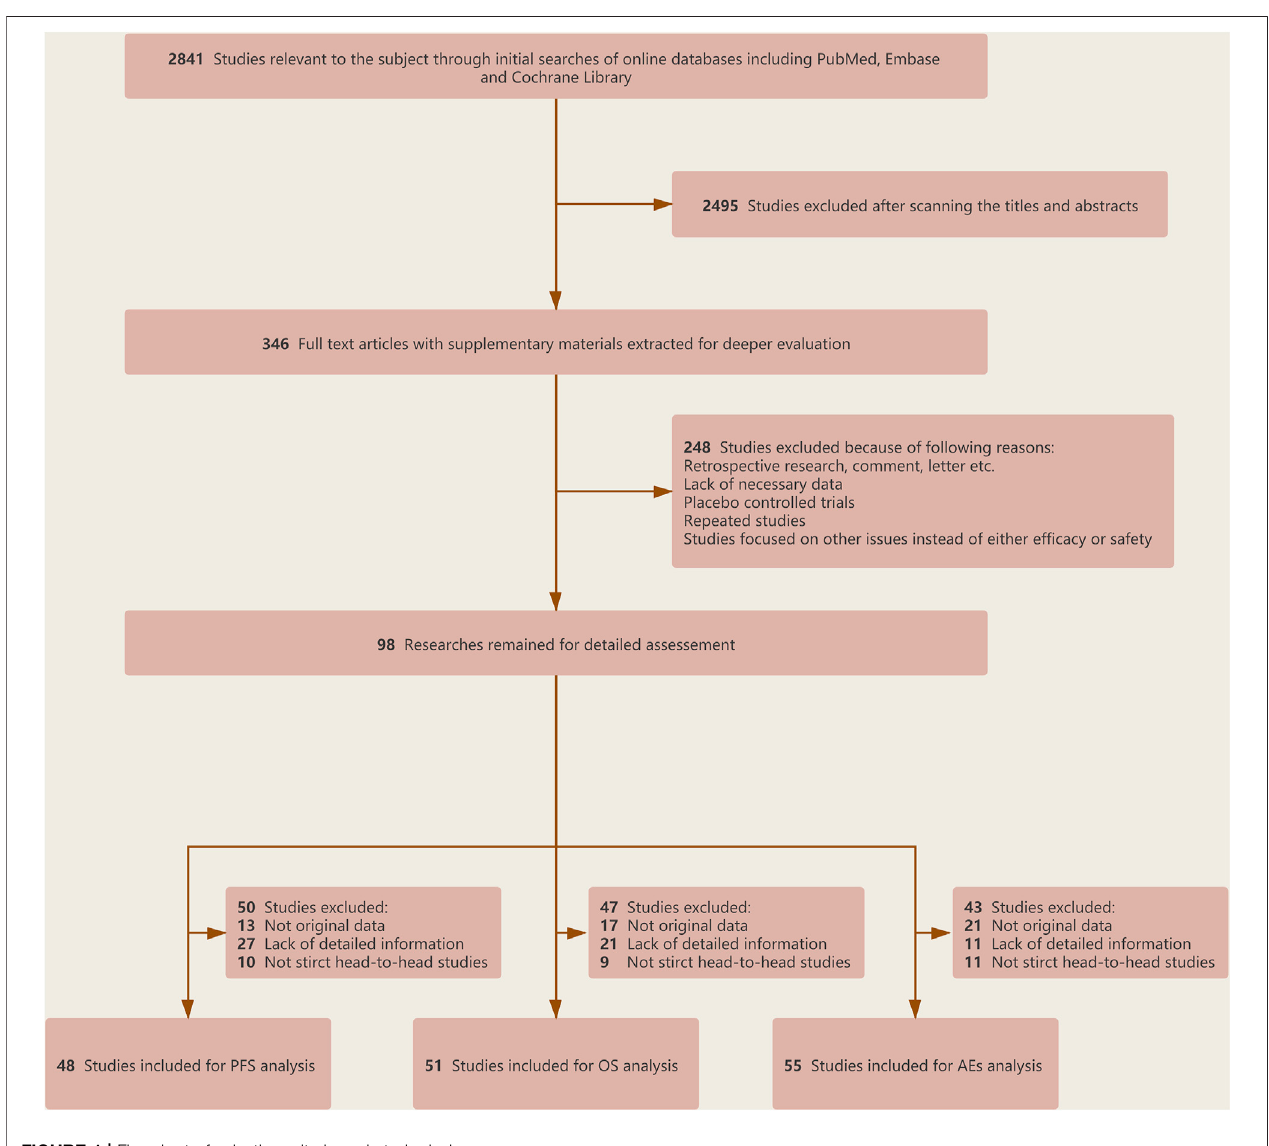
FIGURE 1 | Flowchart of selection criteria and study